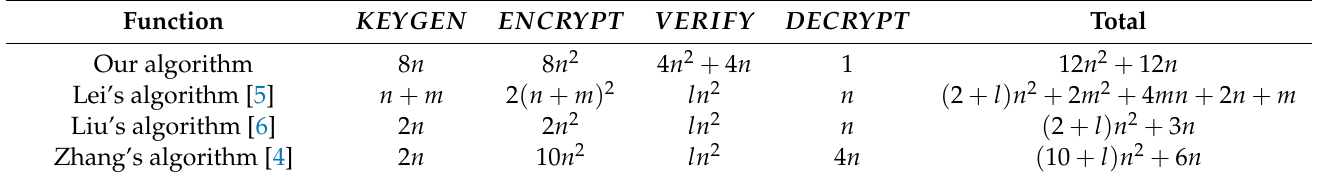
Table 3. Local multiplication burden.